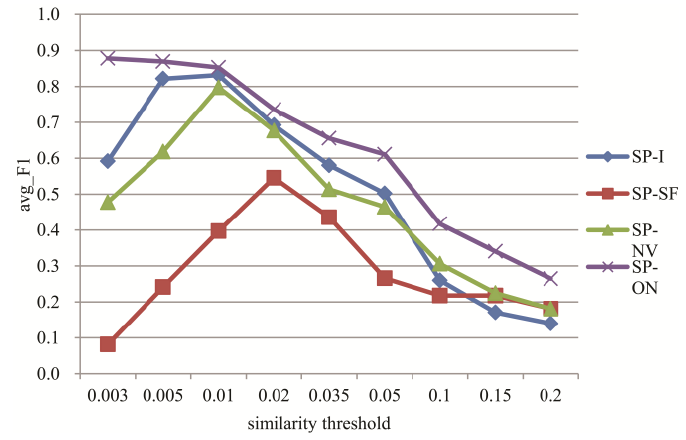
Figure 3. Average F1 measure of microblog clustering for different similarity thresholds.